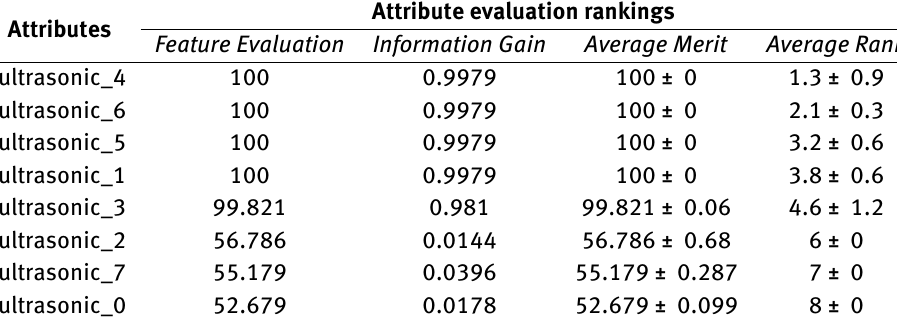
Attribute evaluation rankings